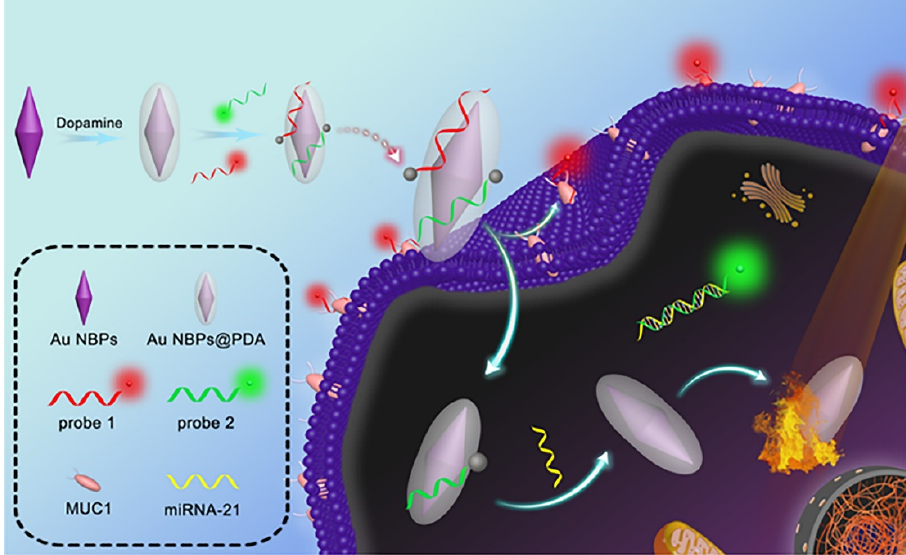
Figure 1. Dual tumor biomarkers with intracellular spatial distribution can be imaged in situ using a multilayer nanoplatform based on multifunctional nanomaterials [56].